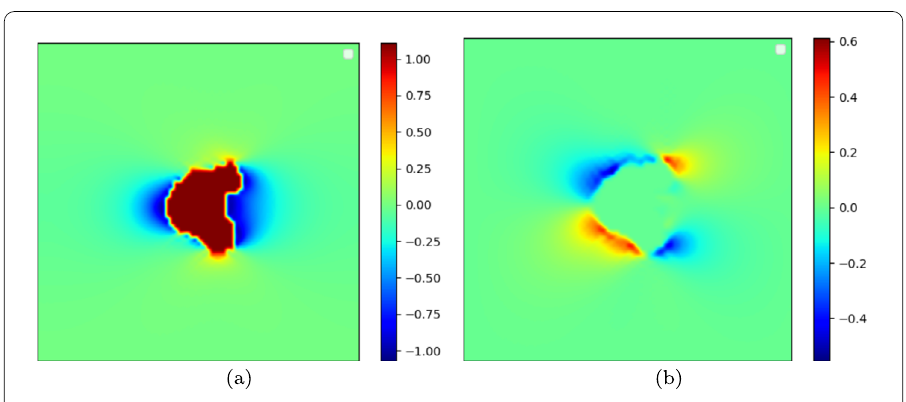
(cid:2) ε (cid:3) = 1% (color yy